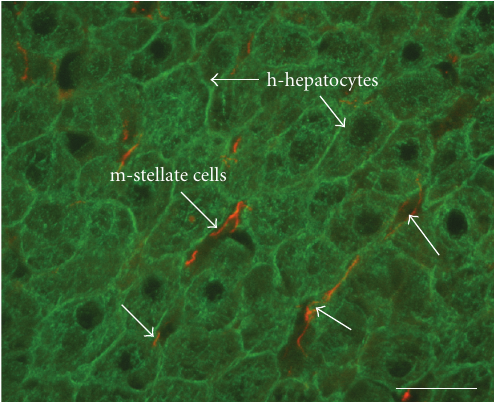
Figure 2: Close natural apposition of m -stellate cells and h - hepatocytes in a chimeric liver. A serial section shown in Figure 1 was doubly stained with h -CK8/18 (green) for h -hepatocytes and m -desmin (orange) for m -stellate cells. The h -hepatocytes are well organized and closely apposed to m -stellate cells in Disse’s space. Arrows indicate representative h -hepatocytes (green) and m -stellate cells (orange). Bar, 10 μ